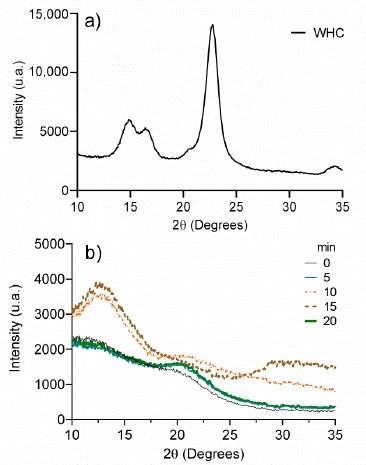
Figure 3. ( a ) X-ray spectrum of cellulose extracted from the wheat husk (WHC) and ( b ) X-ray spectra of regenerated celluloses at different exposure times to UV radiation.